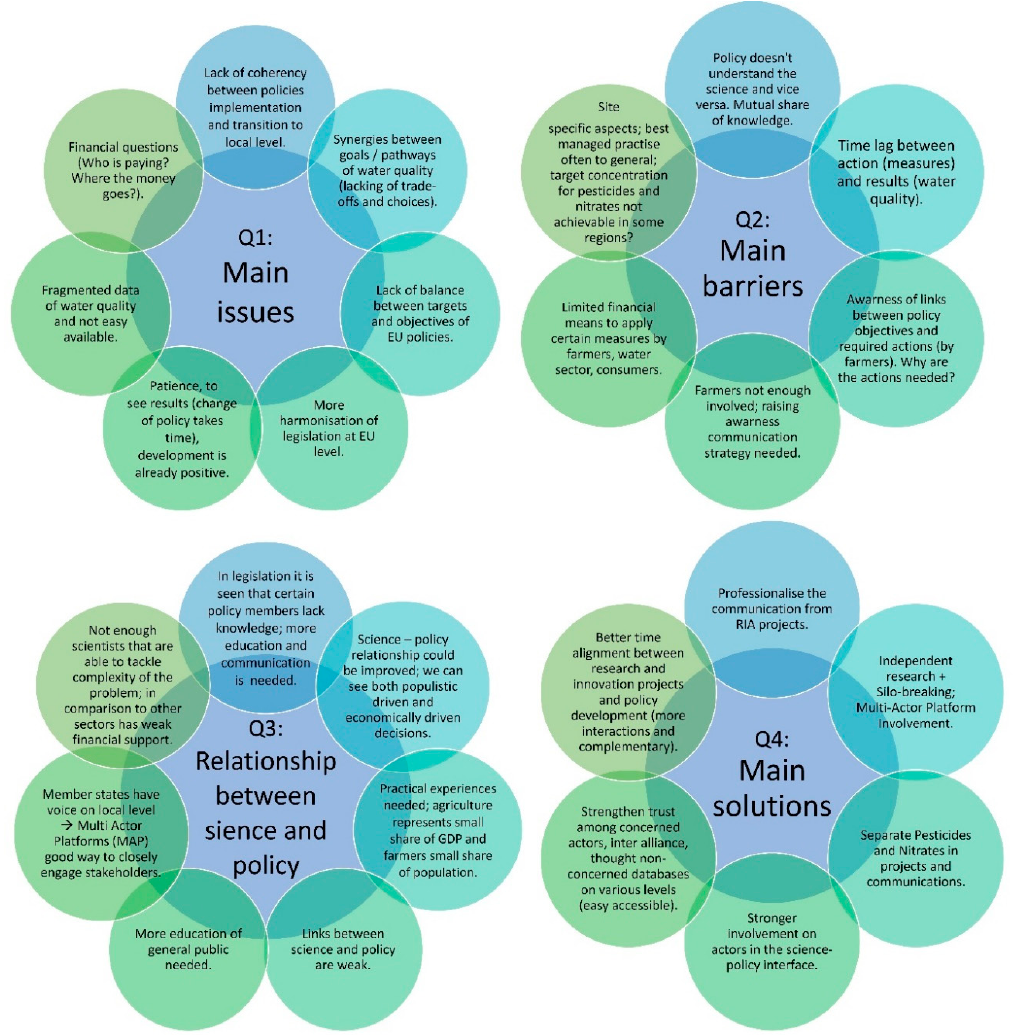
Figure 2. Key points for Questions 1, 2, 3 and 4 on the role of science in EU policy making and implementation related to drinking water resource protection against diffuse pollution of nitrates and pesticides from agriculture in the EU.